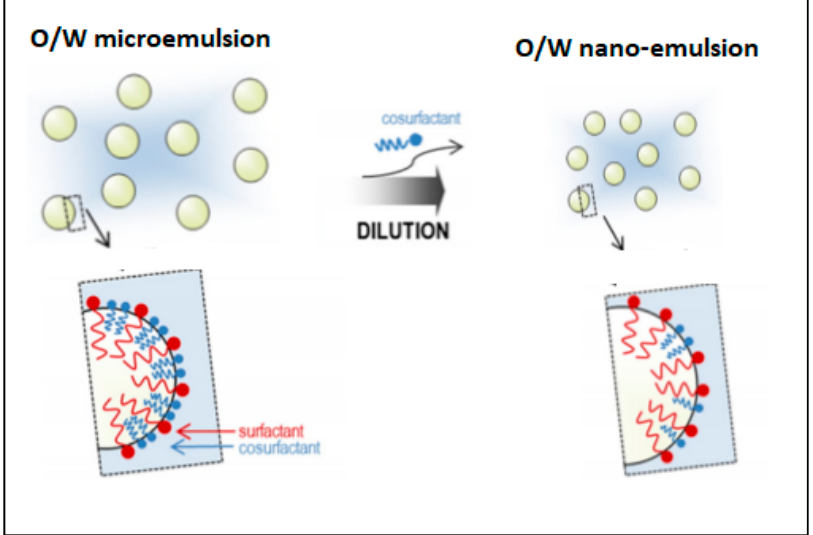
Figure 5. Schematic representation of the self-emulsification method by the dilution of an O/W microemulsion. Reproduced with permission from Solans & Solé, Current Opinion in Colloid & Interface Science; published by Elsevier, 2012 [70].